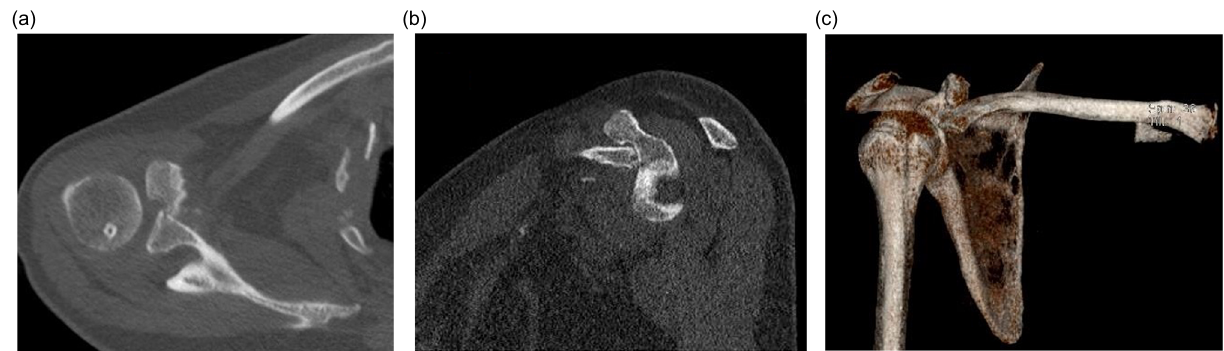
Figure 2. (a) Axial, (b) sagital, and (c) 3D computed tomography images of the right shoulder 8 weeks after injury demonstrating subcoracoid dislocation of the distal